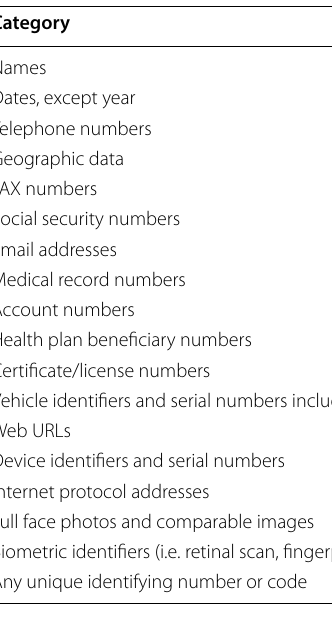
Table 1 18 Categories of HIPAA PHI